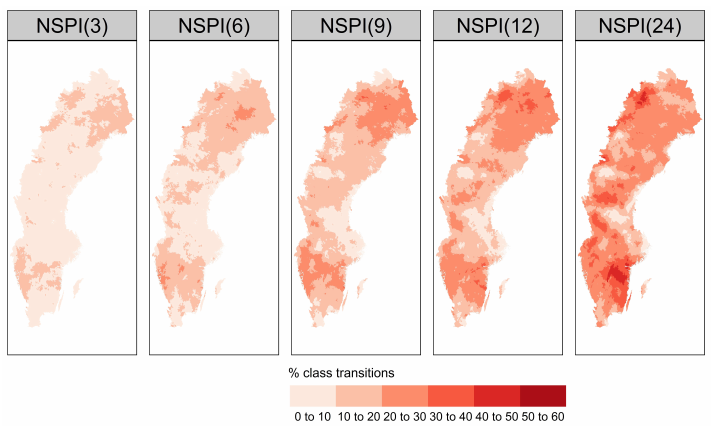
Figure 10. Percentage of drought class transitions for different scales of SPI, using the non-stationary Gamma distribution, across 36,662 basins.